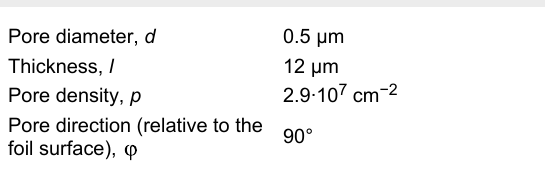
Table 1: PET track membranes characteristics. Pore diameter,